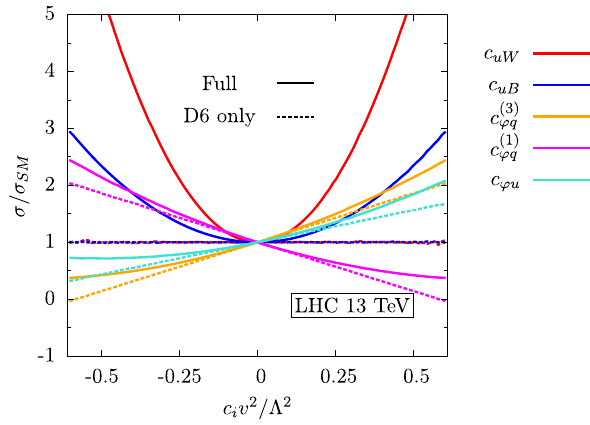
Fig. 1 Ratio of the full SM pp → t ¯ tZ cross-section with the opera- tors of Eq. (II.4) switched on individually to the NLO Standard Model estimate. The dashed lines show the contribution from the interference term, and the solid lines show the full